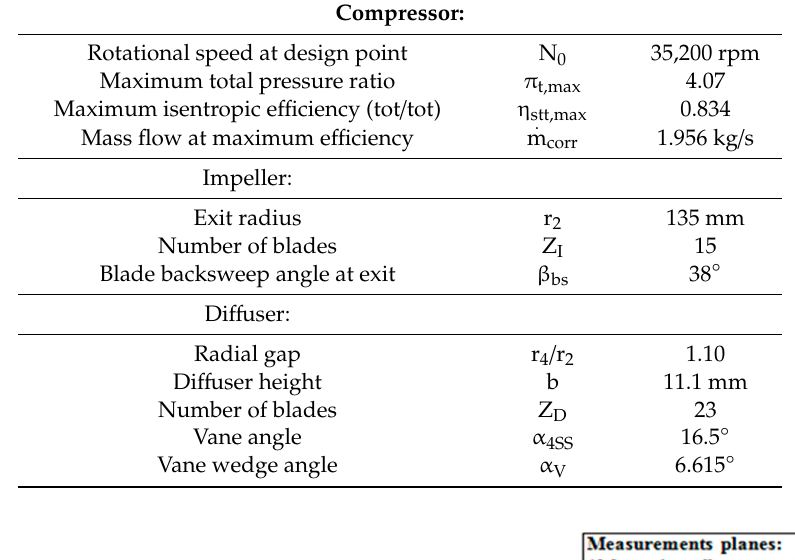
Table 1. Technical data of compressor for nominal speed and di ff user reference geometry.